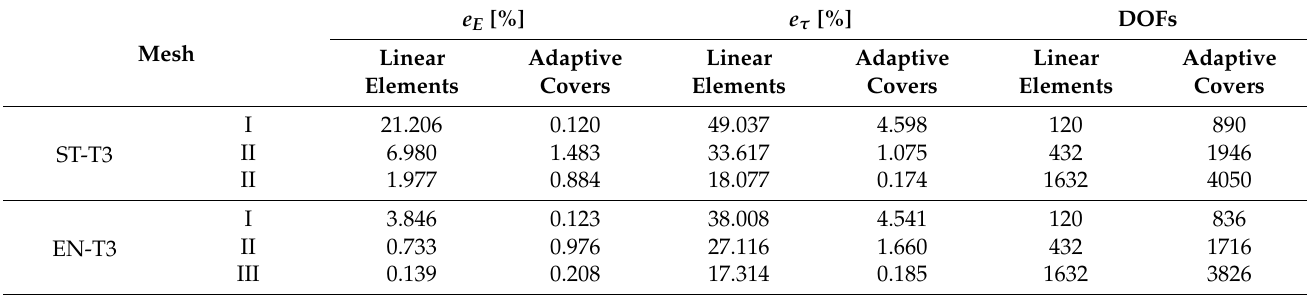
Figure 16. Von Mises ( τ ) predictions obtained by the standard and edge-based smoothed four-node triangular finite elements (ST-T3 and ES-T3) and the adaptive enrichment scheme for the L-shape structure problem when the Mesh III is used. Table 6. Relative errors (%) in the energy norm ( E ) and the maximum von Mises stress ( τ ) in the L-shape structure problem when the meshes of triangular elements (ST-T3, ES-T3) are